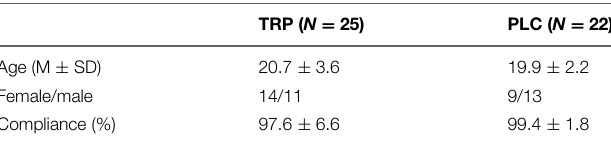
TABLE 1 | Demographic characteristics of the tryptophan (TRP) and Placebo (PLC) groups ∗ .